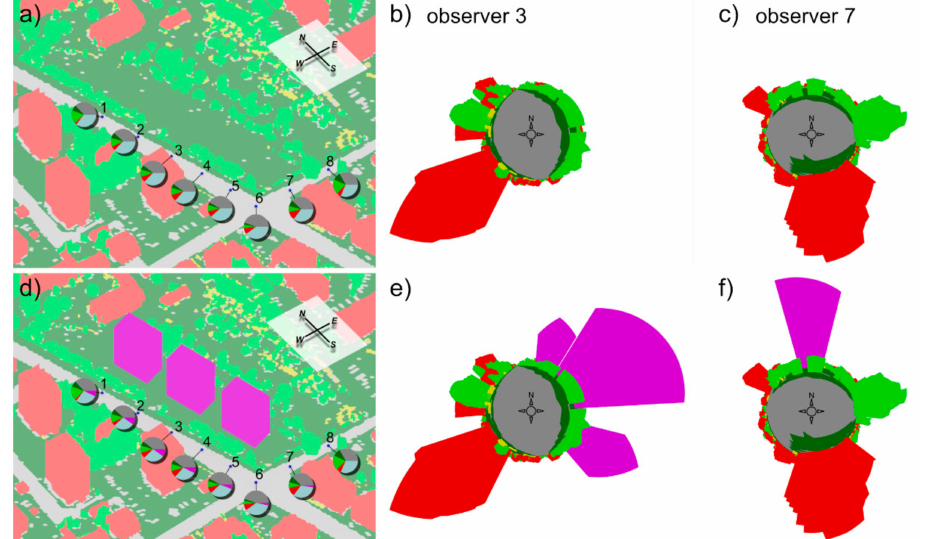
Figure 10. Landscape features’ percentage distribution ( a ) and little planet charts for observer 3 ( b ) and 7 ( c ); landscape features’ percentage distribution after the construction of new buildings, ( d ) and little planet charts for observer 3 ( e ) and 7 ( f